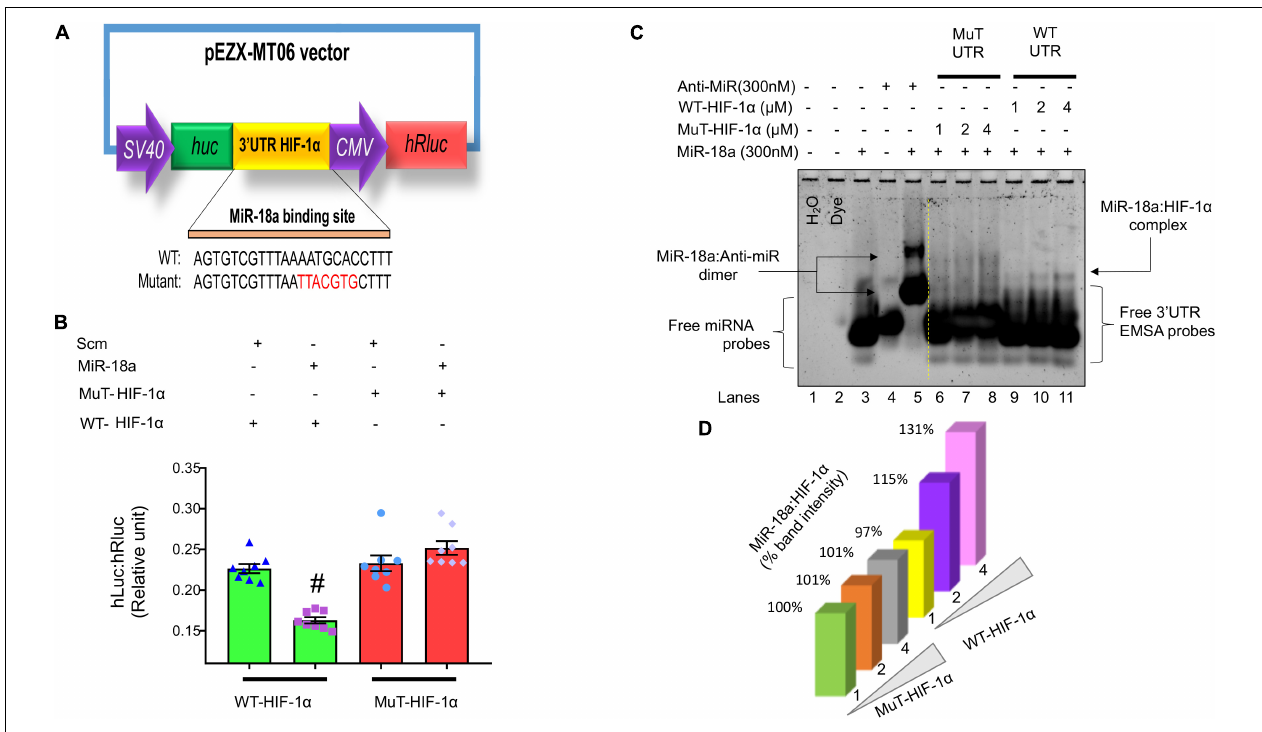
FIGURE 11 | MiR-18a-5p targets HIF-1 α 3 (cid:48) UTR. (A) Dual-luciferase reporter assay construct showing WT and mutant miR-18a-5p binding sequences. (B) Luciferase reporter quantification showing relative expression of luciferase activity in miR-18a-5p, or scrambled miRNA-treated H9c2 cells co-transfected with either WT or mutant HIF-1 α 3 (cid:48) UTR, dot represents individual values, n = 8 wells/group. # P < 0.05 vs. WT-HIF-1 α 3 (cid:48) UTR, two-way ANOVA. (C) MiRNA–mRNA EMSA showing binding affinity of miR-18a-5p with WT or mutant HIF-1 α 3 (cid:48) UTR (1, 2, or 4 µ M). (D) Quantification of miR-18a-5p % band intensity shift with 1, 2, or 4 µ M of WT or mutant HIF-1 α 3 (cid:48) UTR